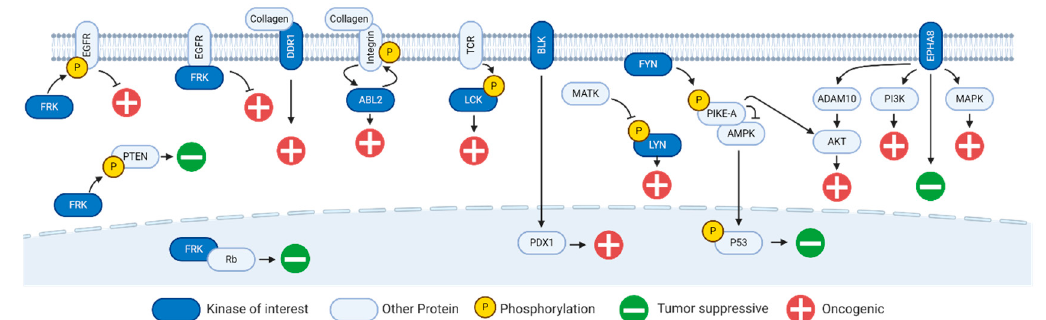
Figure 1. Simplified signaling pathways for kinases of interest in PDAC. Lipid bilayer represents cellular membrane; dashed line represents nuclear membrane; blue ovals represent kinases of interest; gray ovals represent other proteins; yellow circles represent phosphorylation; green circles represent downstream tumor suppression; red circles represent downstream oncogenicity or tumor promotion.